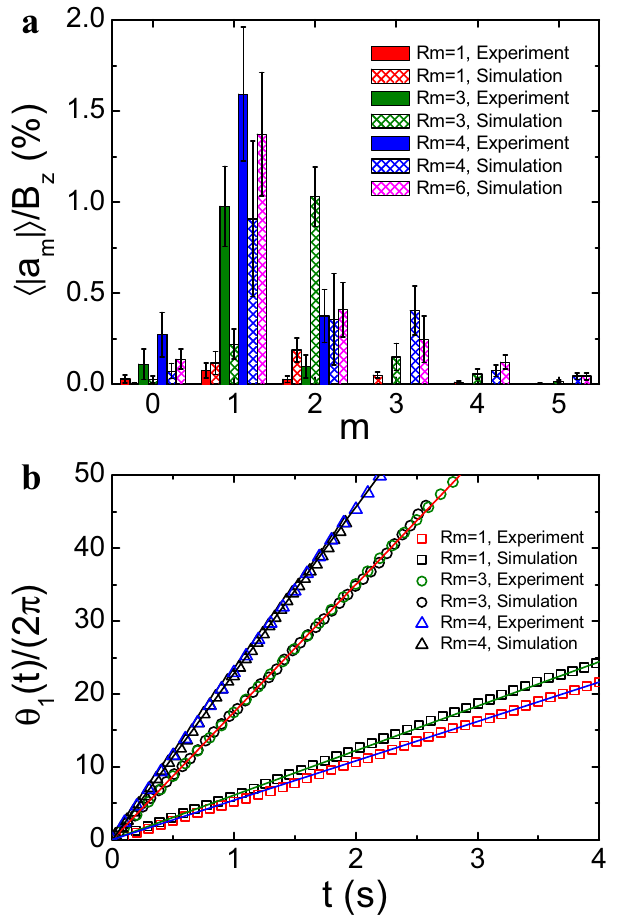
Fig. 2 | Azimuthal structure of the instability. a Normalized mode amplitudes 〈 ∣ a m ∣ 〉 / B z in the experiment (solid bars) and simulation (crosshatching bars), as a function of azimuthal mode number m for different values of Rm with a fi xed B 0 =0.2.Measurementsweremadeinthemidplaneoftheinnercylinder.Errorbars show the standard deviation. b Time evolution of the phase θ 1 ( t )/(2 π ) of the m =1 modeinthecorotatingframeoftheinnercylinder.Thelinesshowalinear fi t, θ 1 ( t )/ (2 π )= f 0 t , to the data points with f 0 =22.8Hz (black), f 0 =17.5Hz (red), f 0 =6.1Hz (green) and f 0 =5.4Hz (blue).